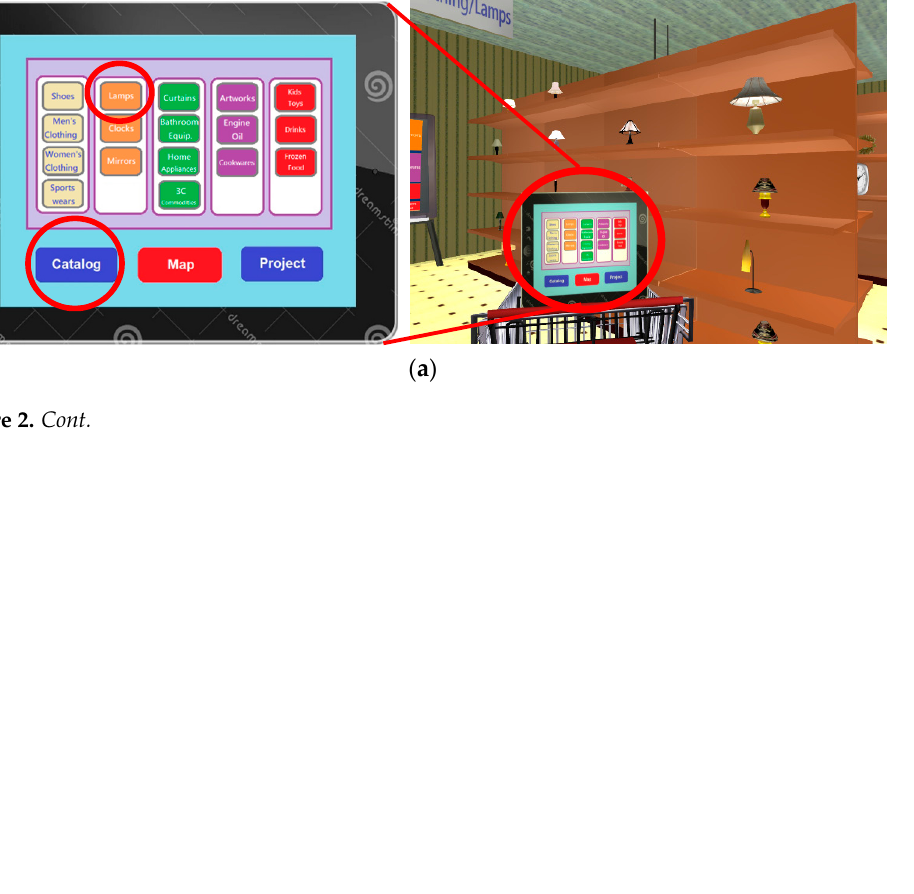
Figure 1. Prototype of the 3D virtual retail store: ( a ) clothes, shoes, and sportswear; ( b ) home appliances and 3D commodities; ( c ) lamps, artwork, and clocks; ( d ) children’s toys, drinks, and frozen food.